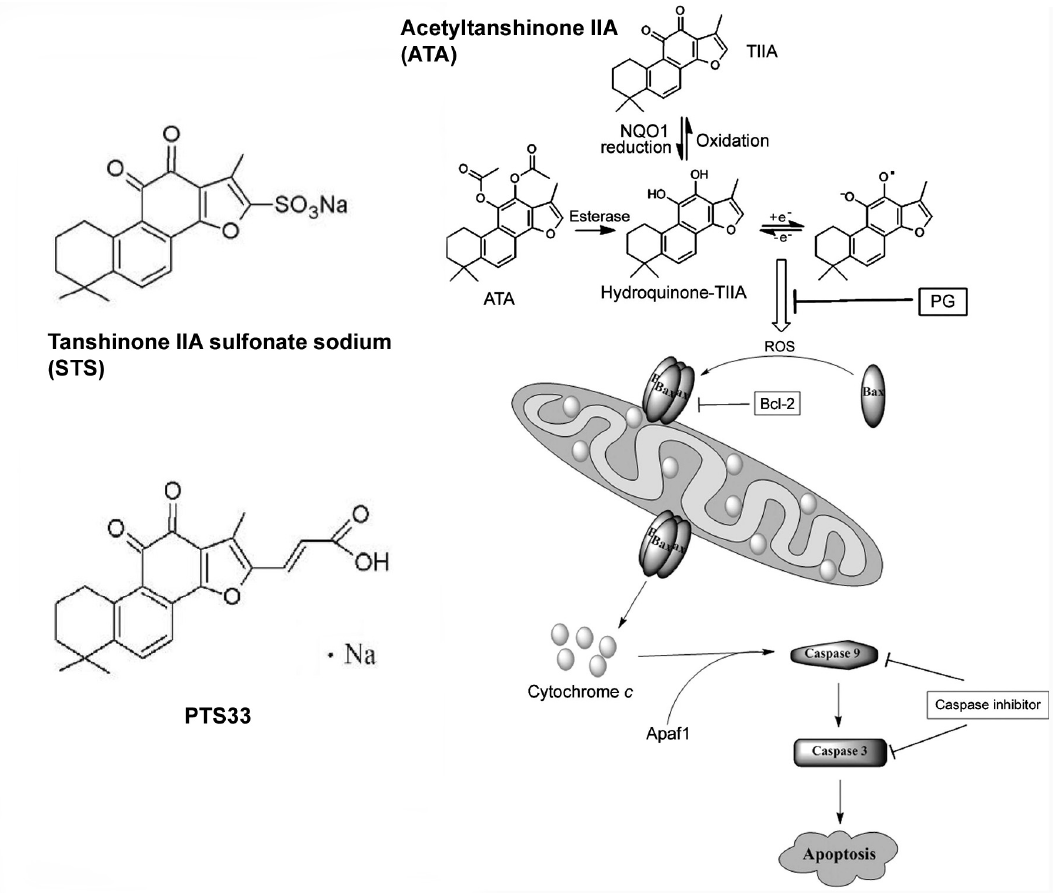
Figure 3. Structures of tanshinone derivatives with increased water solubility. ATA and its likely metabolism [116]. By permission of Elsevier